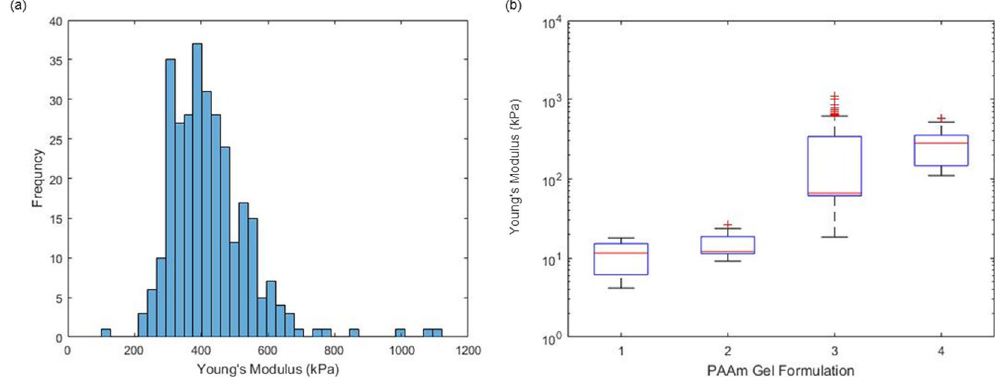
Figure 6. ( a ) Wet AFM data obtained on PAAm sample formulation 3 showing a histogram of the spread of moduli values for 3 repeats of 100 indentations on a 5 × 5 μ m sampling area and ( b ) box and whisker plot showing the overall spread across the range of PAAm samples tested. All AFM experiments were conducted with an indentation depth of between 500 and 1000 nm and each curve was done over 1 s, 900 repeats per formulation were conducted with three samples per